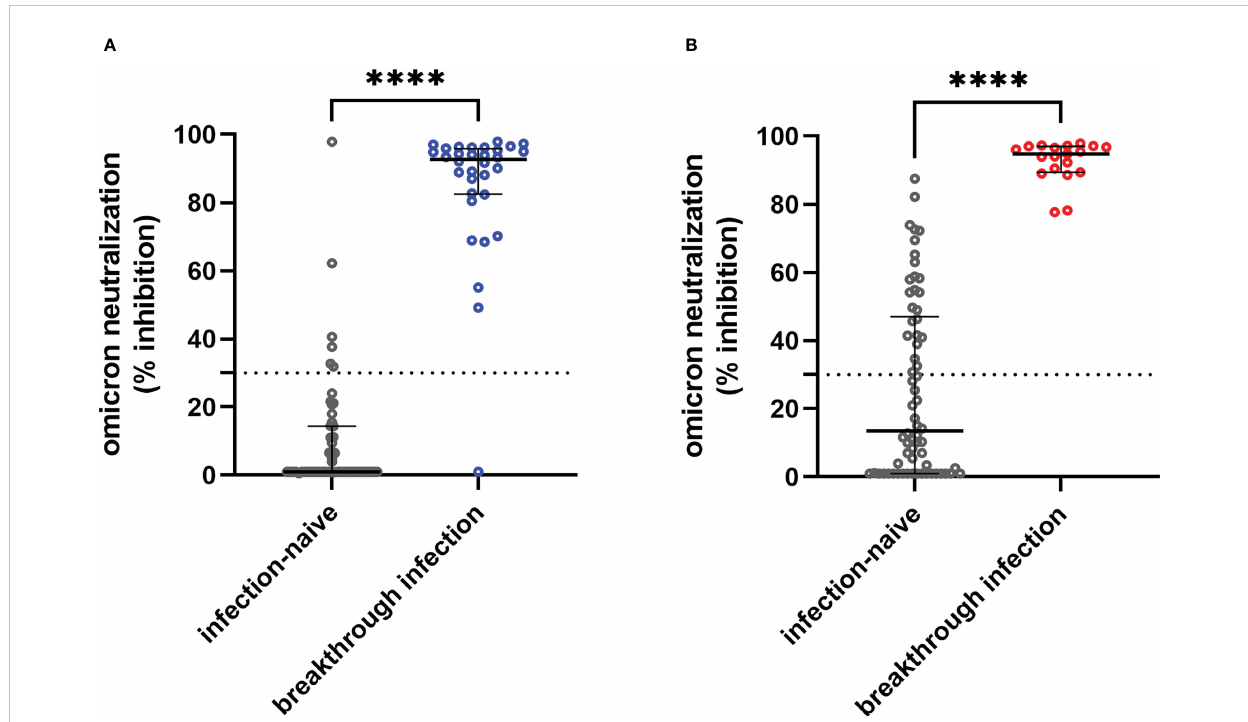
FIGURE 4 Comparison of omicron neutralization activity between infection-naïve and breakthrough infection groups. Plasma neutralization activity against omicron in samples collected in a 6 th sampling window. The dots represent individual participants (blue: participants with breakthrough infection in the ChAd-BNT cohort, red: participants with breakthrough infection in the BNT-BNT cohort, and black: infection-naïve participants in both cohorts). The neutralizing potency was compared between infection-naïve and breakthrough infection groups in ChAd-BNT (A) and BNT-BNT (B) cohorts. The assay cut-off is presented as a horizontal dotted line. **** P < 0.0001 by Mann-Whitney U